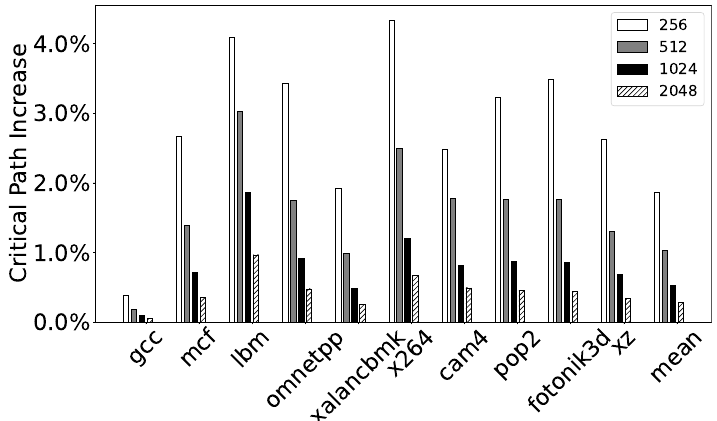
Figure 6. Critical path increase for different sampling